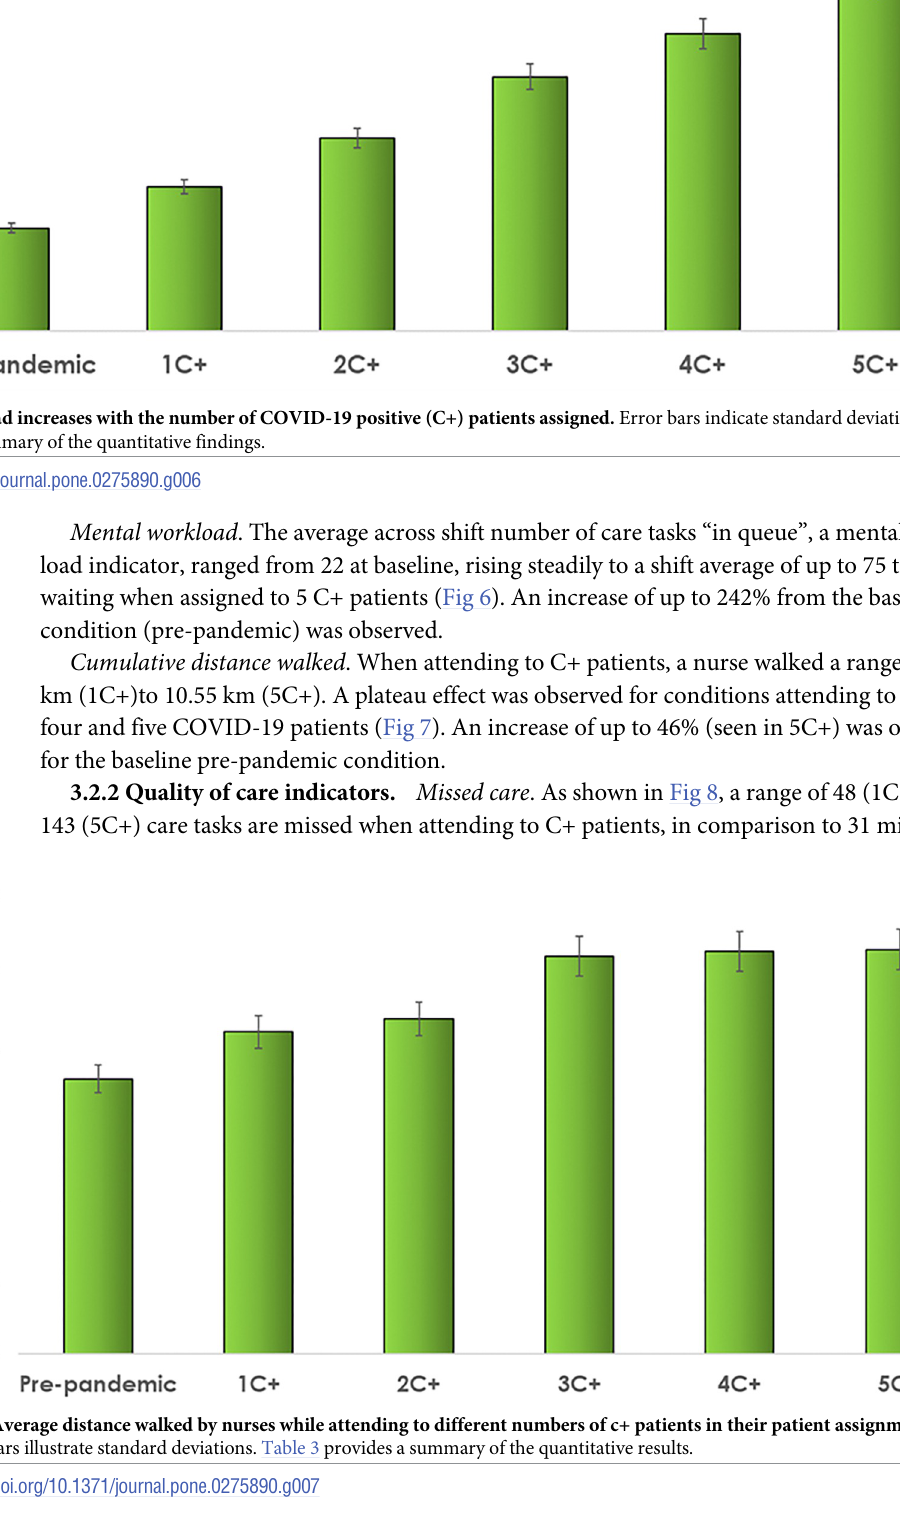
PLOS ONE | https://doi.org/10.1371/journal.pone.0275890 October 13,